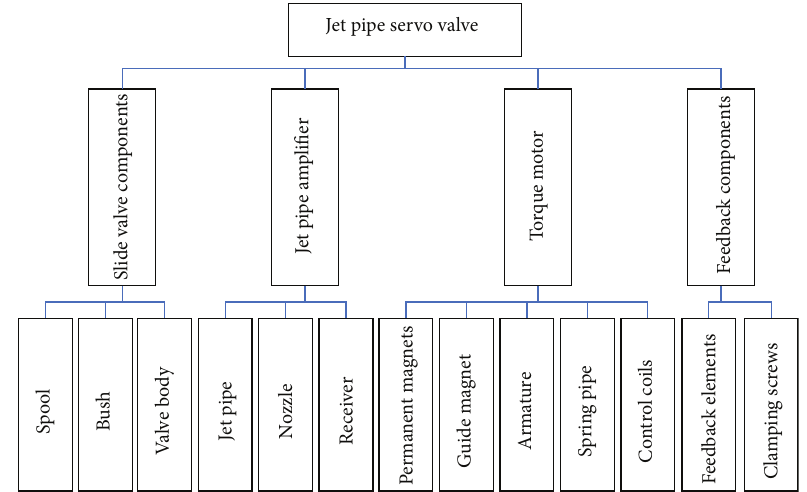
Figure 1: The structural decomposition block diagram of jet pipe servo valve.